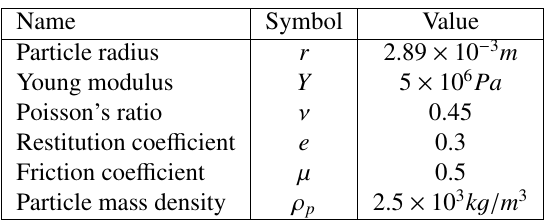
Table 1: Material and compression parameters used for the simulation.